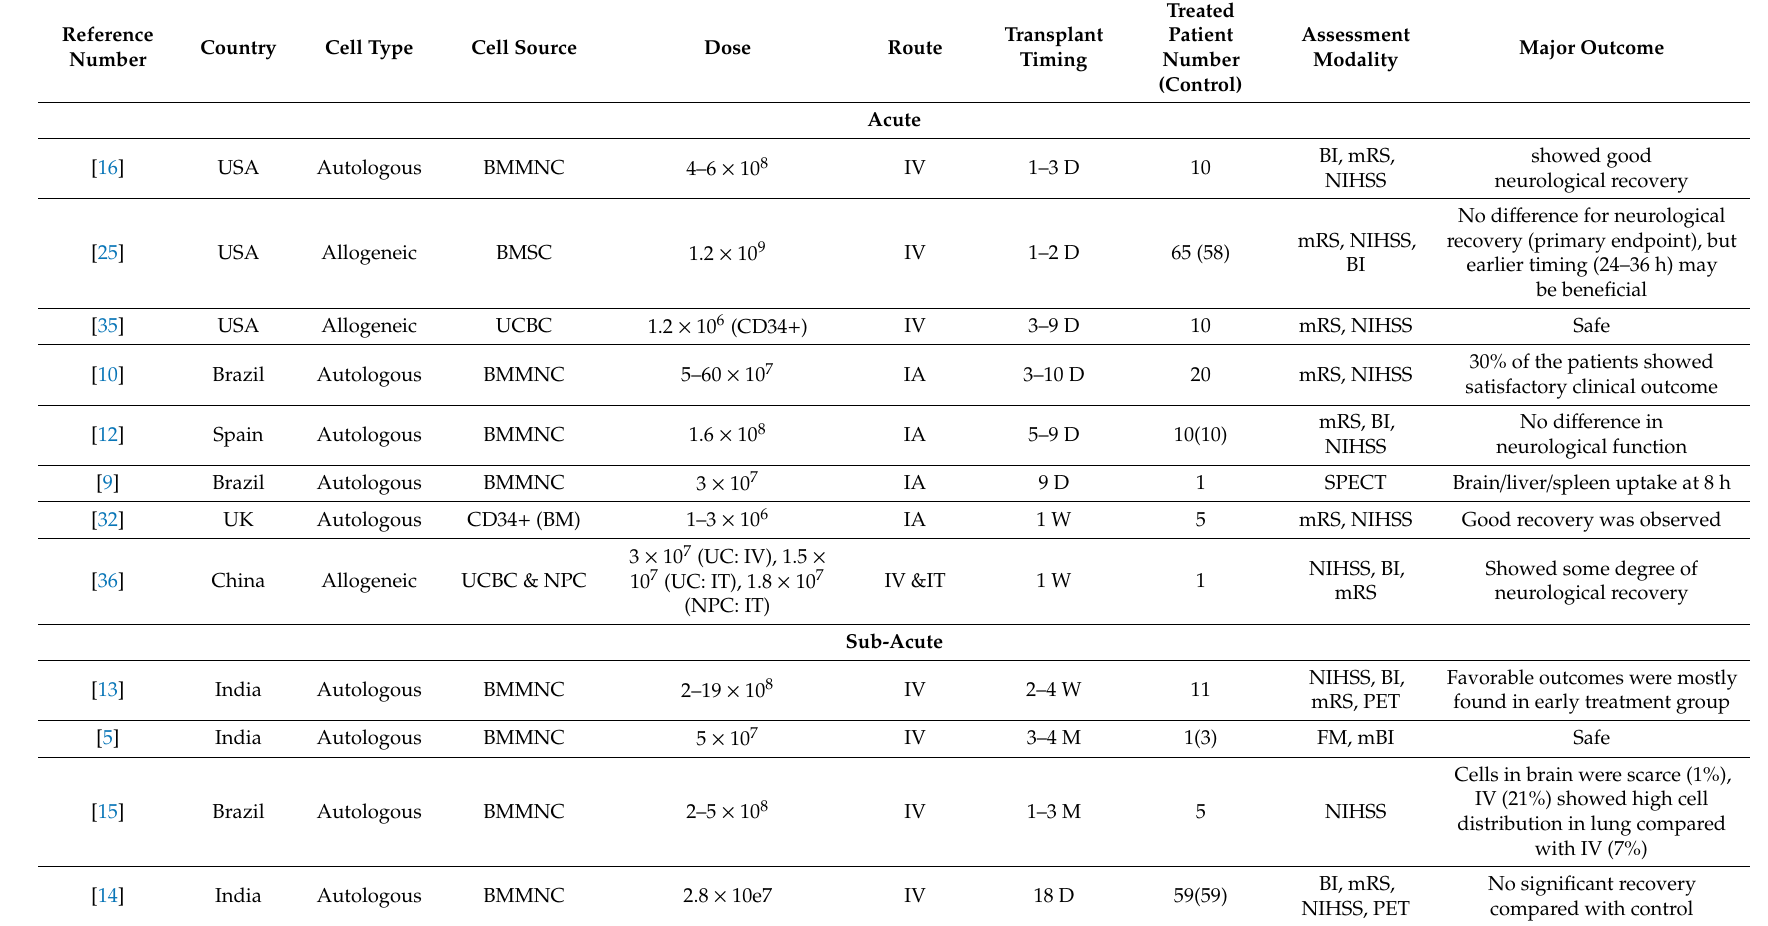
Table 1. Published clinical trials using stem cells for ischemic